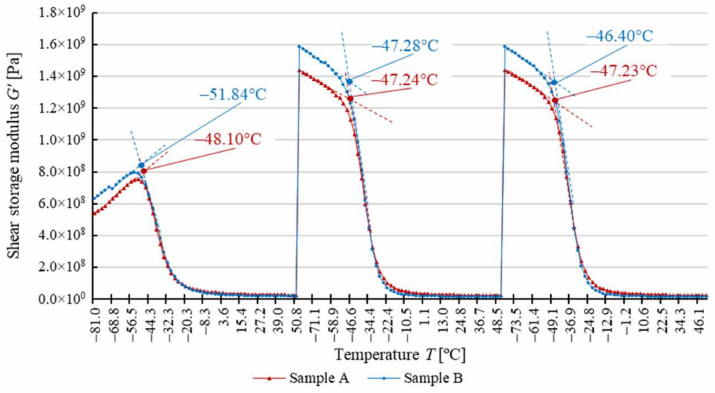
Figure 8. Determination of polyurethane glass transition temperature based on the shear storage modulus G (cid:48) .